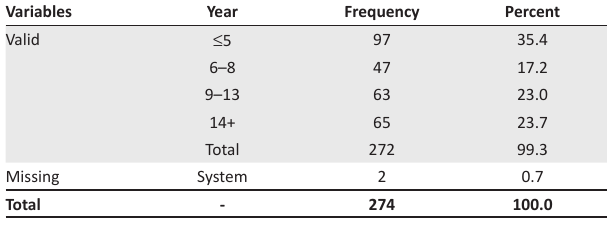
TABLE 6: Number of years served as heads of department.